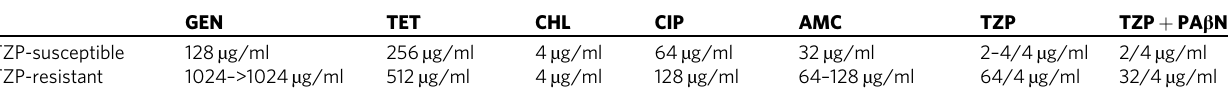
Table 1 Minimum inhibitory concentrations of the piperacillin/tazobactam-resistant and piperacillin/tazobactam-susceptible isolates.